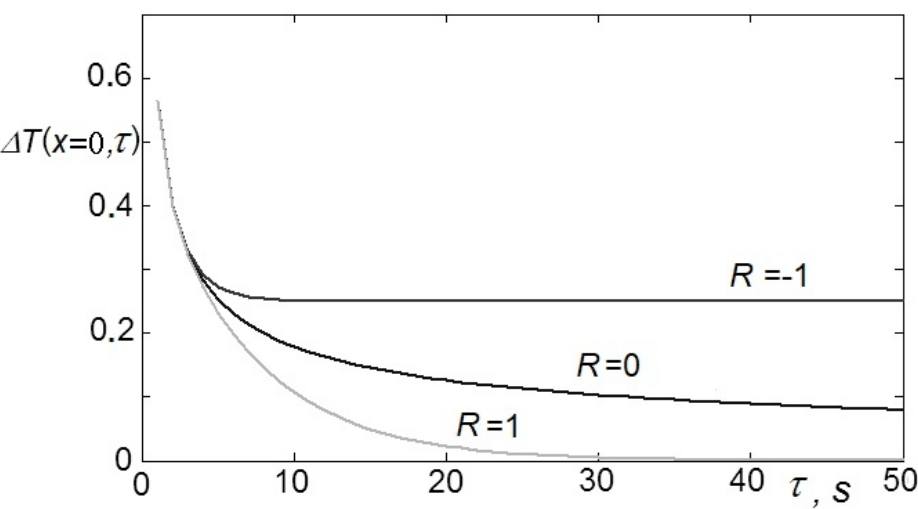
Figure 4. Temperature rise of the surface of a homogeneous material ( R = 0) and of a material with a defect R ≠ 0 for a pulse excitation as in Equation (17). defect R (cid:54) = 0 for a pulse excitation as in Equation